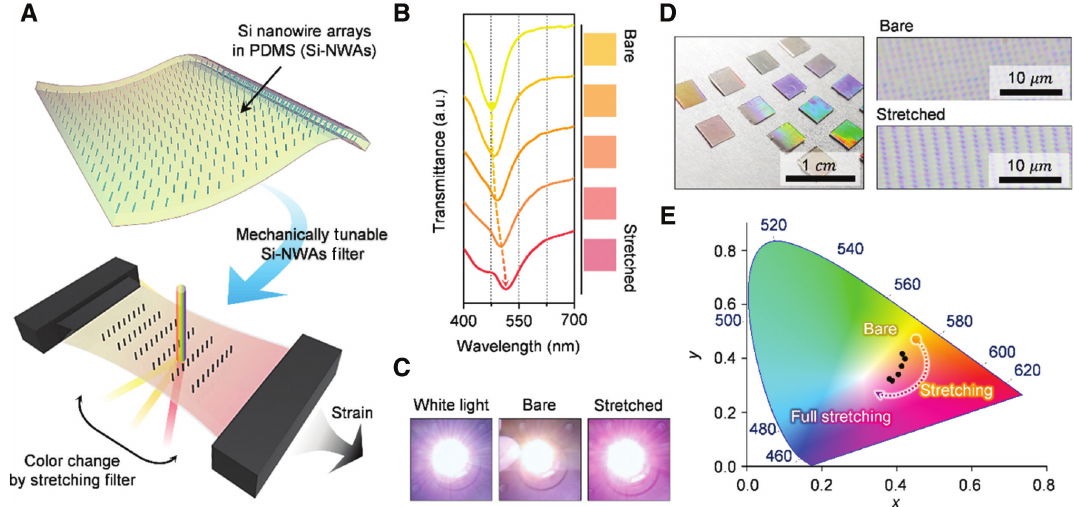
Figure 1: The mechanically tunable Si nanowire optical filter with spectral tunability. (A) Schematic illustration of the tunable nanowire color filter. (B) Transmittance curves of the Si-NWAs and color representation of the stretched Si-NWAs. (C) Tunable transmissive color filter properties comparing the bare and full stretching samples. (D) Photographs of the Si-NWAs with different periods and diameters (left), microscope images before and after stretching Si-NWAs (right). (E) The color representations of the bare and stretching